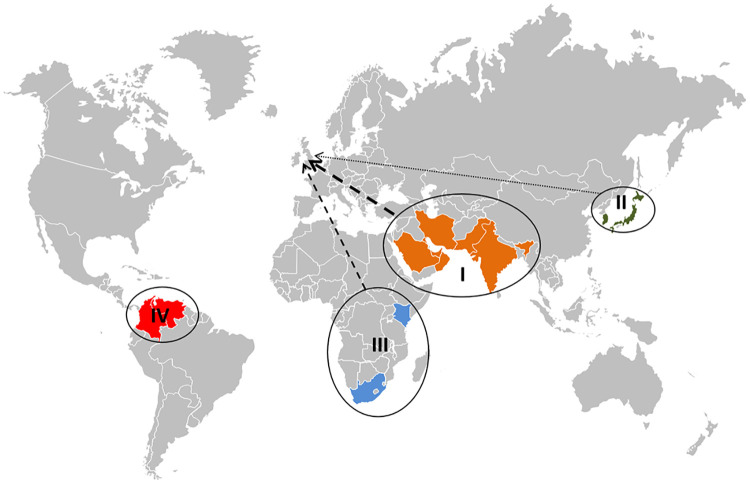
World map depicting the purported origins of the 4 major Candida auris clades; clade I (Southern Asia), clade II (East Asia), clade III (South Africa), and clade IV (South America).The dashed arrows represent clades that have been introduced into the UK, with line thickness proportional to the estimated numbers of separate introductions. (World map by: www.freeworldmaps.net
https://www.freeworldmaps.net/powerpoint/).